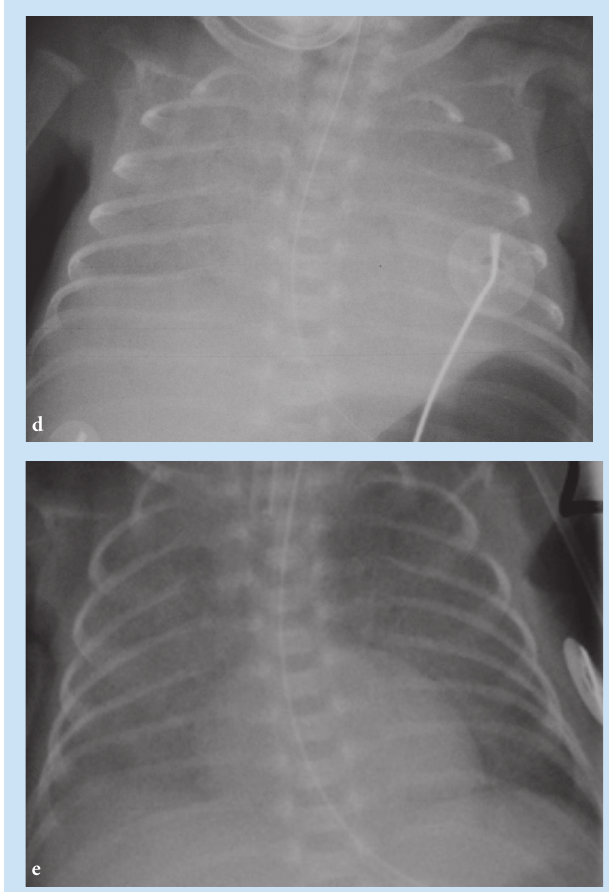
Fig. 19 (a) - (e). Hyaline membrane disease / ARDS. There is progres- sion from a bilateral symmetrical diffuse granularity of the lungs to a more confluent airspace process with loss of cardiac and diaphragmatic margins and eventual ‘white out’. There may be some improvement in a patchy distribution when surfactant is ‘sprayed’ down the ET tube. Lung volumes should be small BUT this is not often a radiological feature as the patient requires positive pressure ventilation which gives the impression of large lung